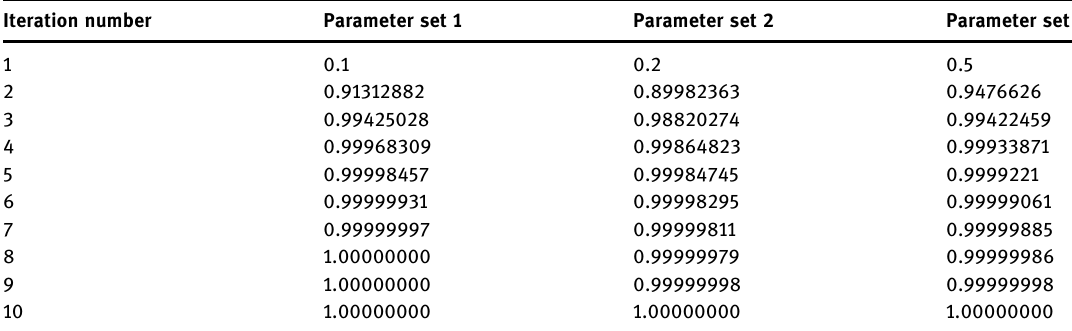
Table 3: Values of iterations in respect of di ff erent set of parameters